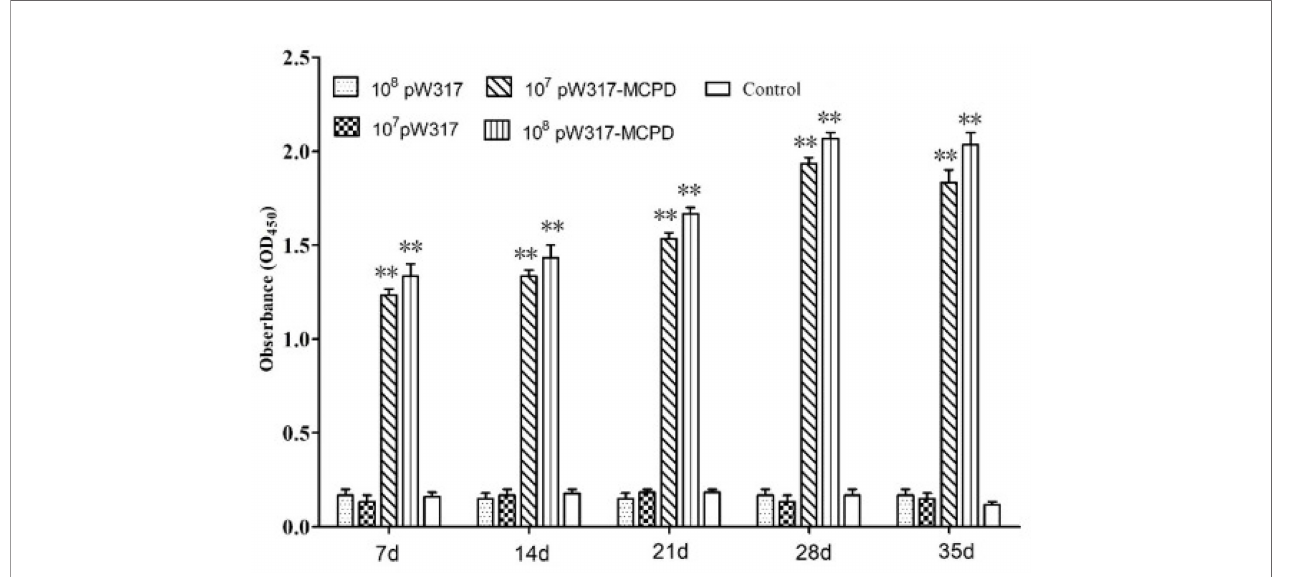
FIGURE 2 | The levels of serum antibody. Serum was collected from the fi sh at 7, 14, 21, 28, and 35 dpi, and serum antibodies against MCPD were determined by ELISA. Three replicates were set for the tests, with three fi sh per replicate. Data are means for three assays and presented as the means ± SE. **P < 0.01. 10 7 pW317: 10 7 CFU/g GS115-pW317; 10 8 pW317: 10 8 CFU/g GS115-pW317; 10 7 pW317-MCPD: 10 7 CFU/g GS115-pW317-MCPD; 10 8 pW317-MCPD: 10 8 CFU/g